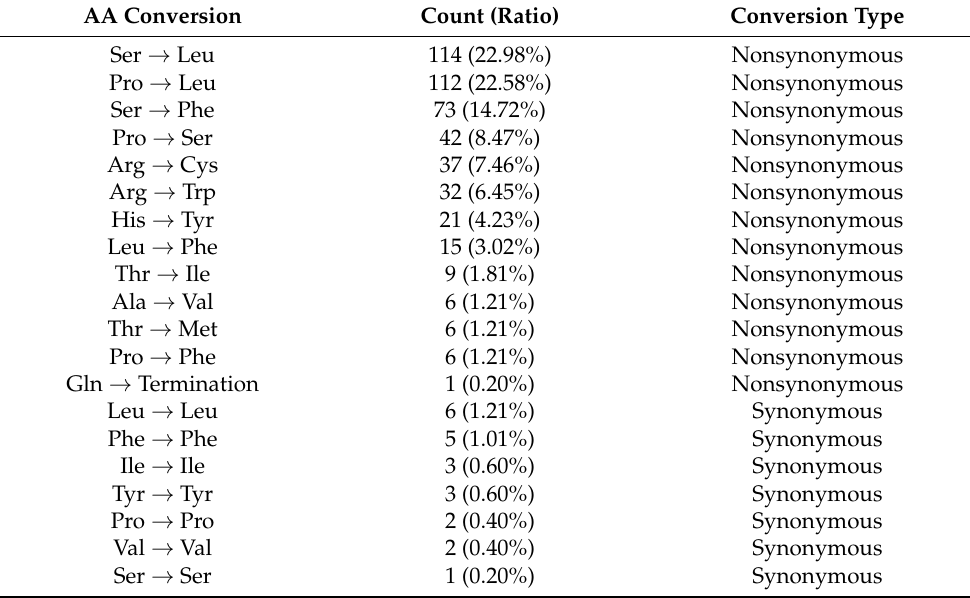
Table 3. Amino acid conversion types caused by RNA editing.